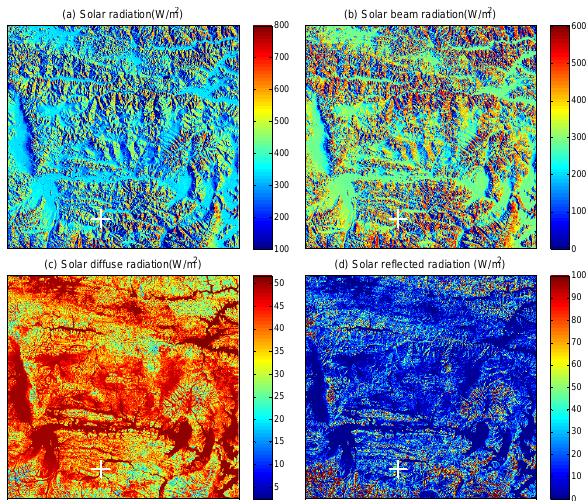
Fig. 6. Distribution of each surface solar radiation item over the Figure 6. Distribution of each surface solar radiation item over the study area of Fig. 1 ( b ) at 885 study area of Fig. 1b at 10:30LT on 9 April 2010, the cross shows 10:30 (LT) on 09 April 2010, the cross shows the location of the station. The geographical 886 the location of the station. The geographical information is the same information is the same as bottom-left picture of figure 1. 887 as bottom-left picture of Fig. 1.